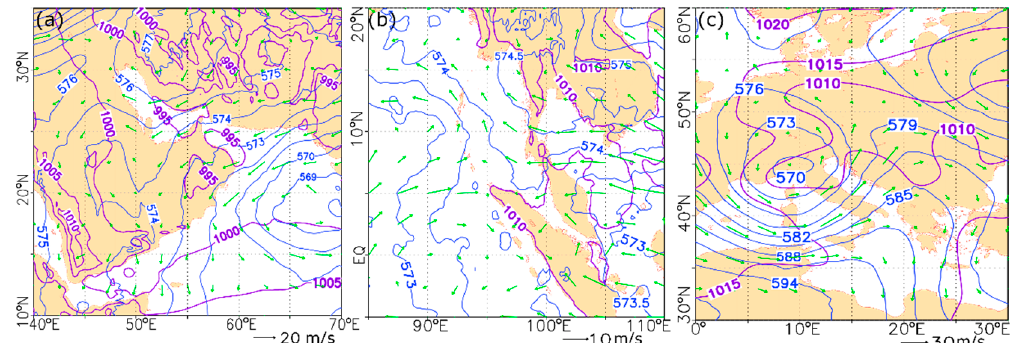
Figure 3. Synoptic charts for: ( a ) The UAE on 17 July 2009 (00:00 UTC); ( b ) Thailand on of 25 July 2007 (00:00 UTC); and ( c ) Serbia on 21 July 2014 (12:00 UTC). Purple and blue lines are the mean sea level pressure (MSLP; in hPa) and the height of 500-hPa pressure surface (in geopotential decameters), respectively. Wind velocity (green arrows) are plotted at 500 hPa. The reference length of wind velocity vector provided below plots. Data are based on GFS (Global Forecasting System) reanalysis at the horizontal resolution of 0.25° × 0.25°.